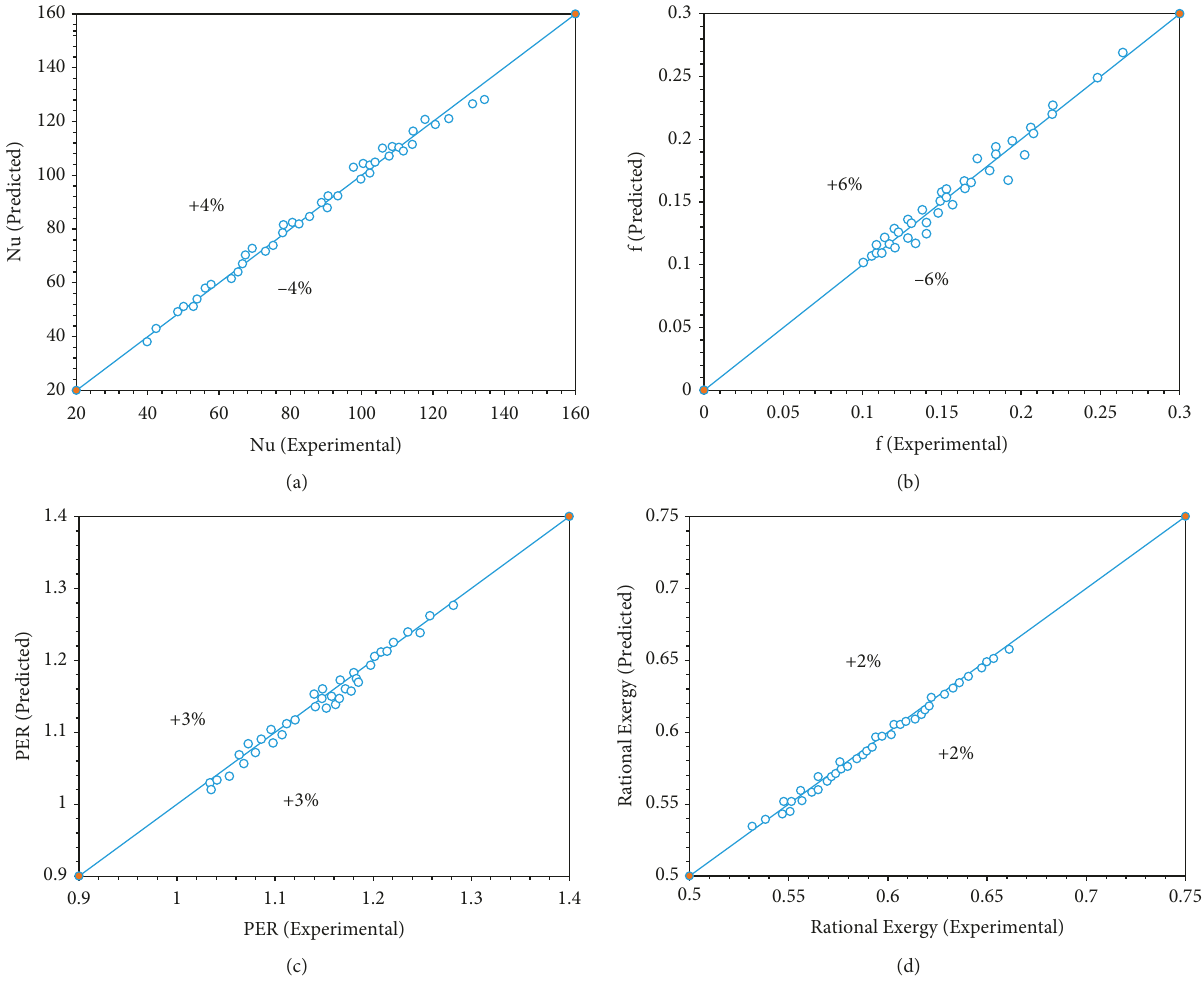
Figure 12: Assessment between the experimental and developed correlation results: (a) Nu, (b) fr, (c) η , (d) η